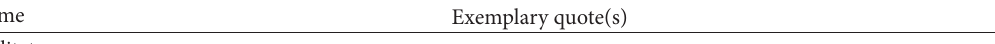
Table 2: Participants’ identified facilitators of healthy